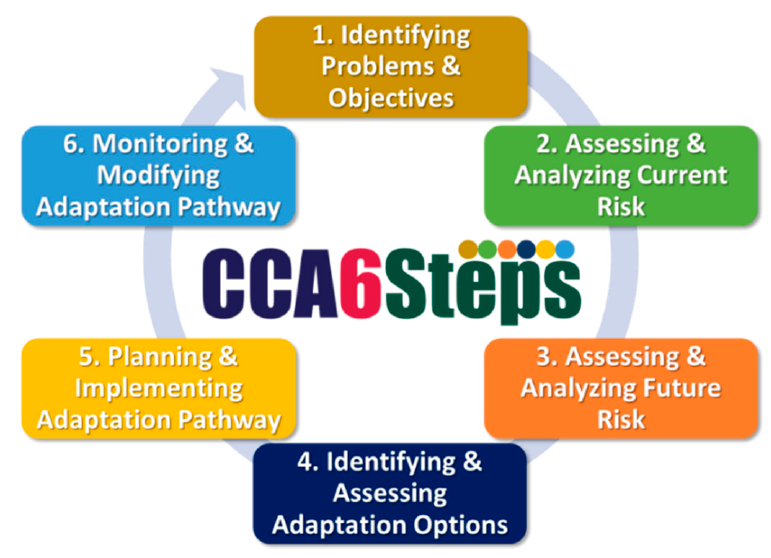
Figure 1. The procedure of Climate Change Adaptation Six Steps (CCA6Steps).